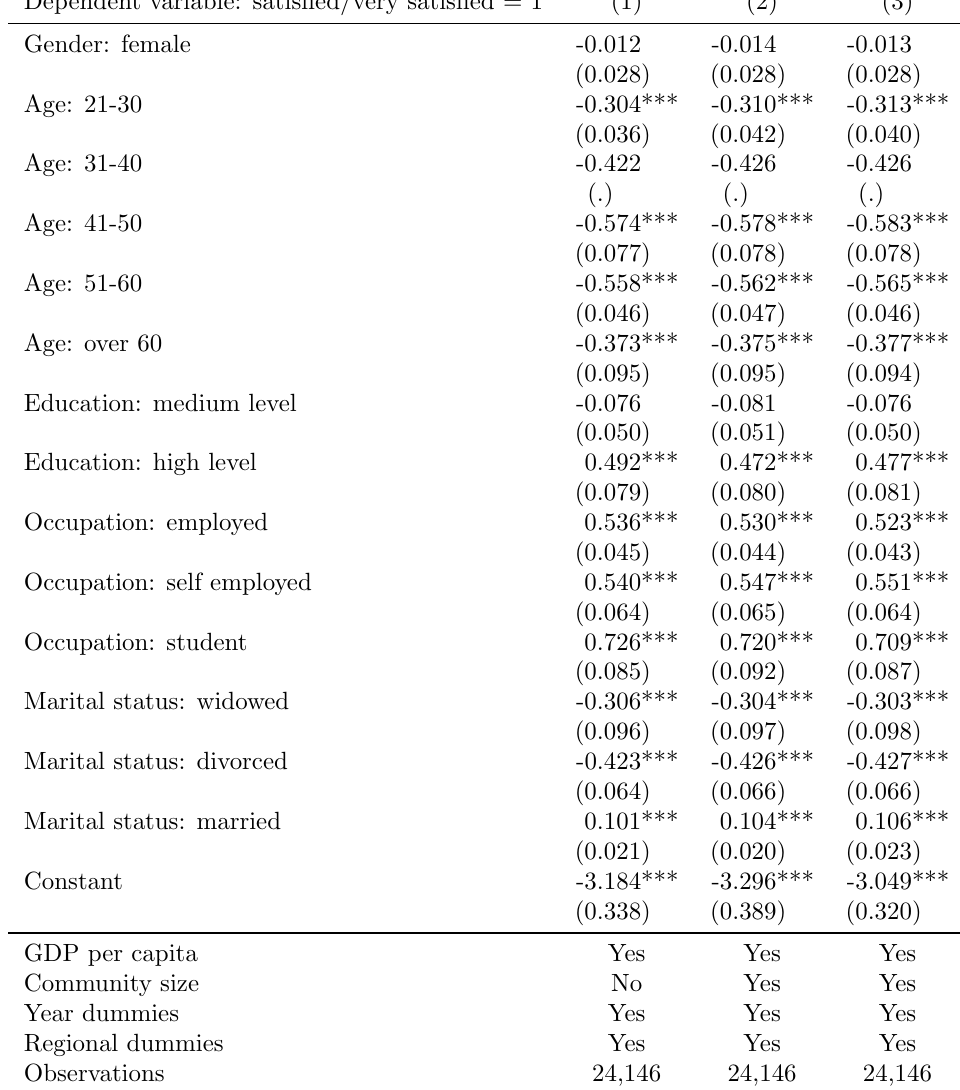
Table A.2: Life satisfaction and individual characteristics of the